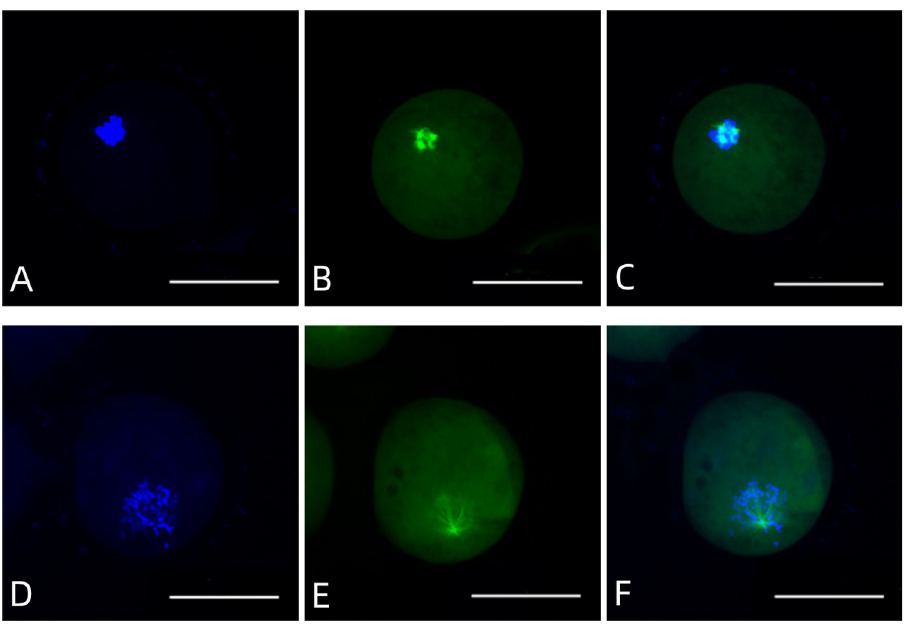
Fig 2. Types of oocytes from guinea pigs and their meiotic progression during IVM. The arrow indicates the first polar body of the matured oocytes, indicating the oocytes have entered the MII phase. (A) Matured oocytes stained with Cell Truck Bule CMF2HC under the microscope after treatment with ROS for 12 hours. (B) Immature oocytes stained with Cell Truck Bule CMF2HC under the microscope after treatment with ROS for 12 hours. (C) After the removal of IMBX, the fluorescence intensity of matured oocytes treated with IBMX was significantly stronger than that treated with ROS. (D) The fluorescence intensity of GSH in MII oocytes cultured in the maturation medium was relatively weaker, and the first polar body was not obvious as well, compared with that cultured in the maturation medium with ROS. (E) The fluorescence intensity of GSH in MII oocytes cultured in MTA medium supplemented with L-cysteine and cystine was stronger than that of GSH in MII oocytes cultured in basic medium. (F) The fluorescence intensity of GSH cultured in the basic medium was much lower than other